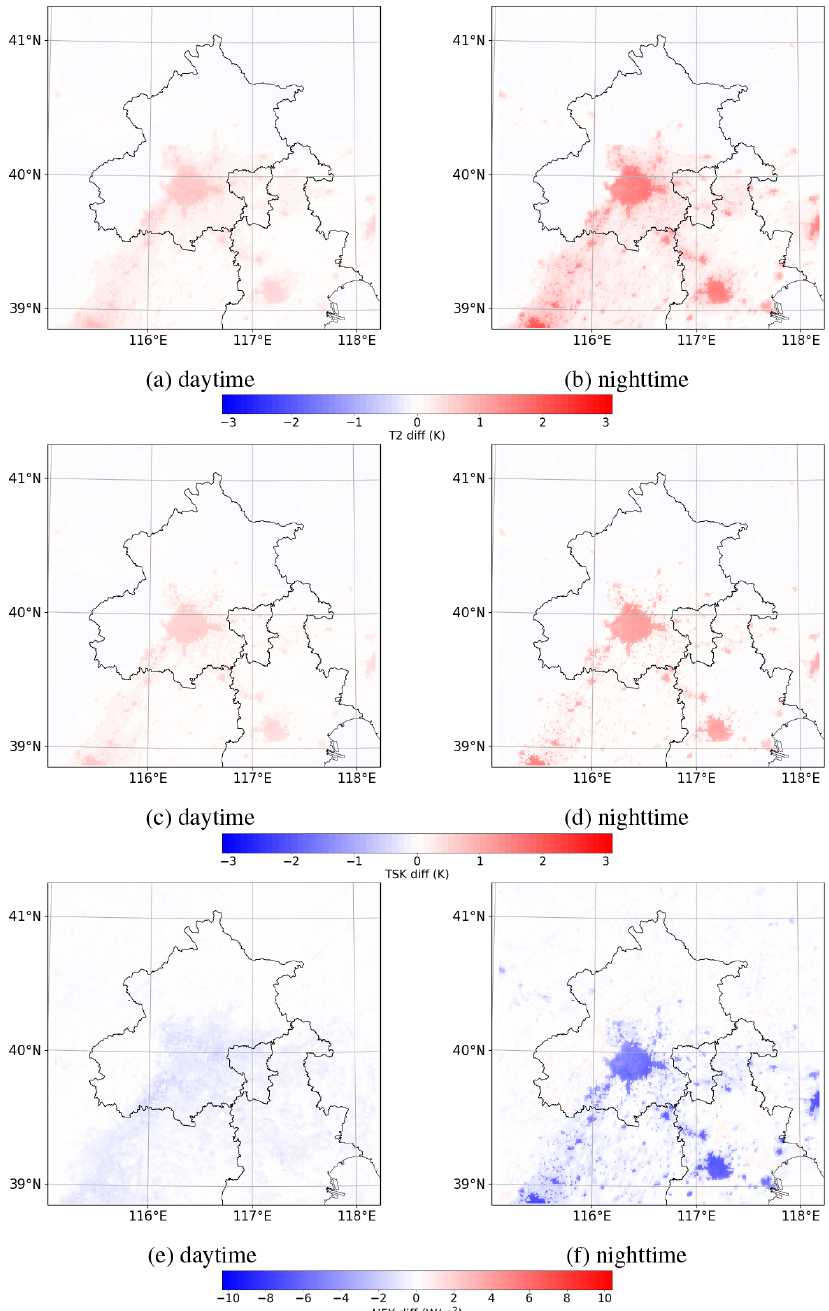
Figure 10. Spatial distribution of the mean differences (ACM2_CMAQ minus ACM2_0.01) in (a, b) T2, (c, d) TSK, and (e, f) HFX over daytime (a, c, e) and nighttime (b, d, f)